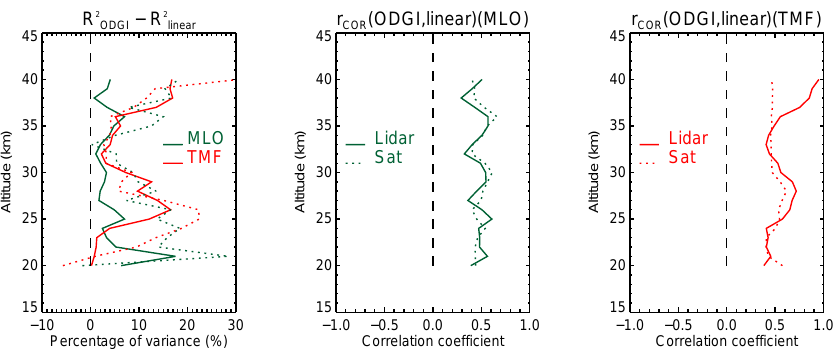
Fig. 10. Left: the difference between the total explained variance calculated with the ODGI or a linear trend with lidar (solid line) and satellite (dotted line) time series. The red colour is use to represent TMF and the green MLO. Centre: correlation coefficient calculated between ozone ODGI and ozone linear response at MLO for both datasets. Right: same for TMF.